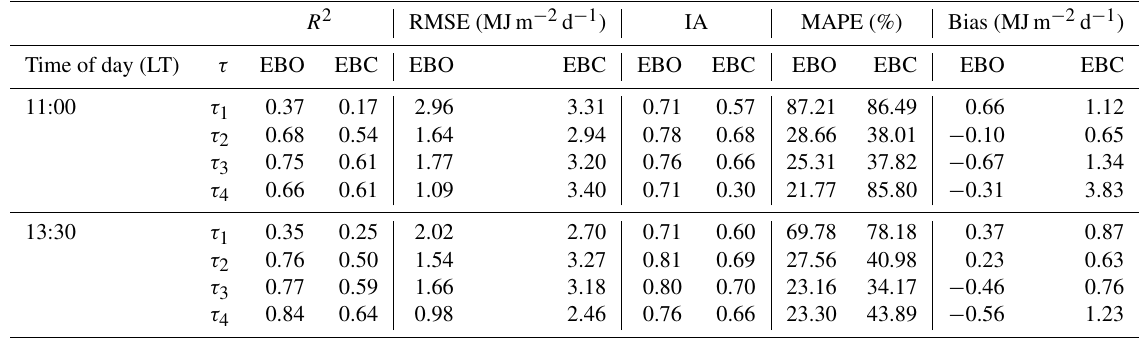
Table 4. Evaluation of the R S -based ANN-predicted ET d (ET d_pred ) error statistics based on “closed” (EBC) and “unclosed” (EBO) surface energy balance under varying sky conditions represented by four different classes of daily atmospheric transmissivity ( τ) . Here τ 1 represents low atmospheric transmissivity due to high cloudiness while τ 4 represents high transmissivity under clear sky conditions. The statistical metrics of ET d_pred for two different upscaling hours (11:00 and 13:30LT) are